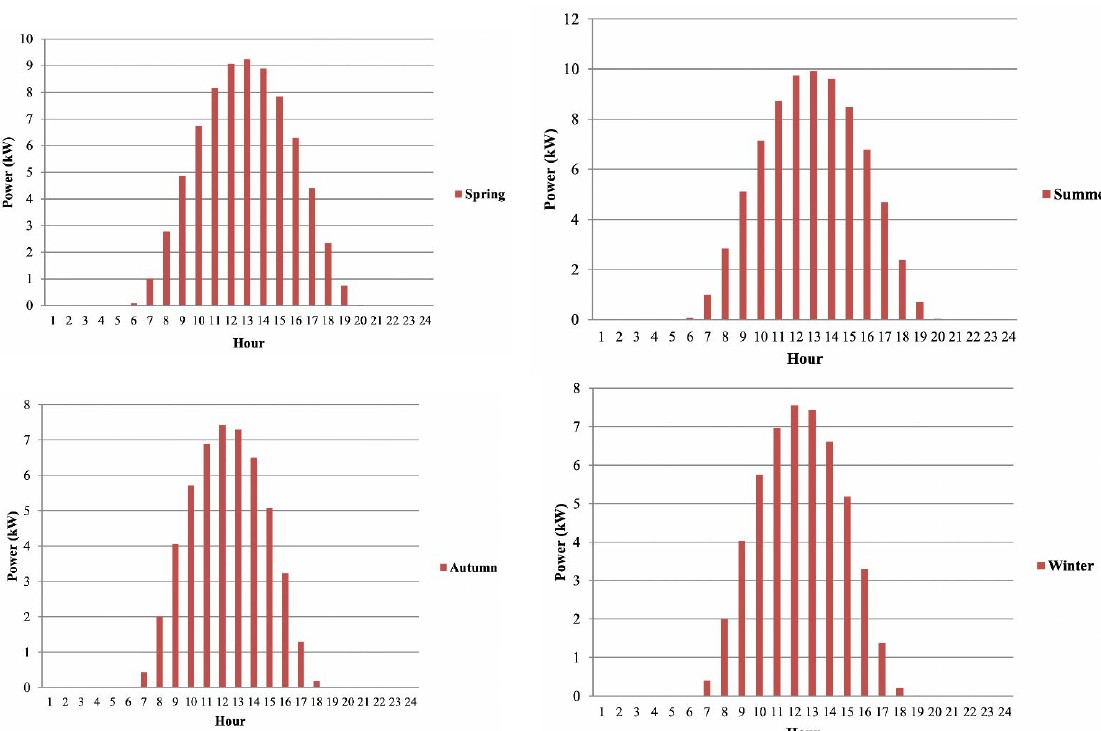
Figure 5. PV/T electricity power generation distribution based on